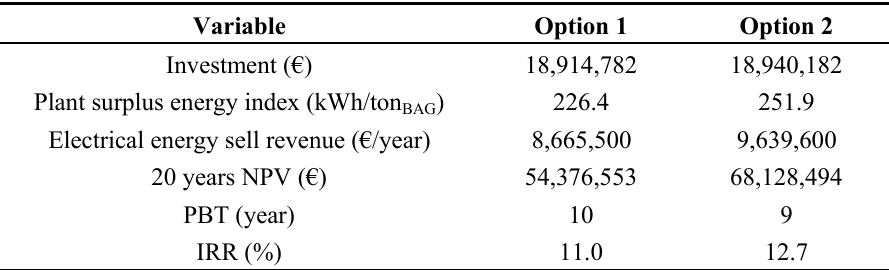
Table 7. Economical comparison of repowering